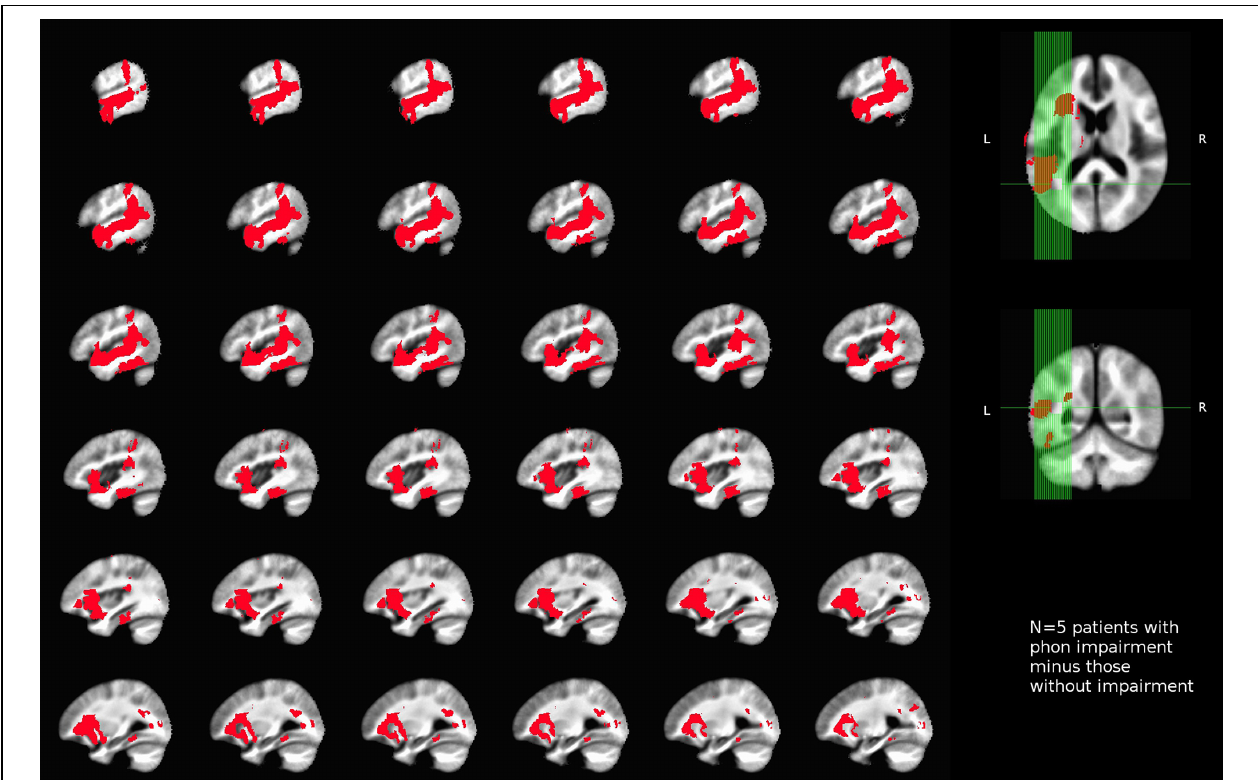
FIGURE 4 | Unthresholded map of areas uniquely associated with impaired performance on the phonological task (rhyming) in our sample of left-hemisphere stroke patients.